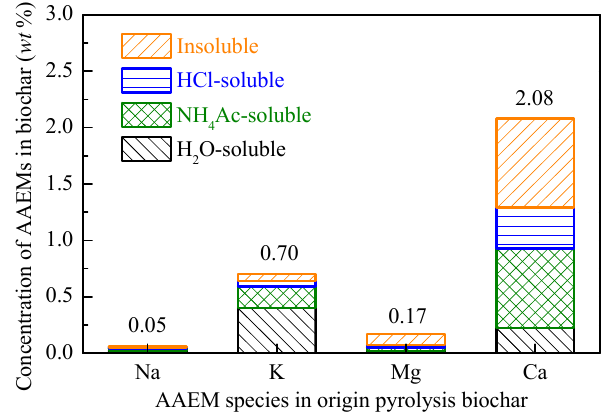
Figure 5. Concentration of AAEMs in origin pyrolysis biochar.